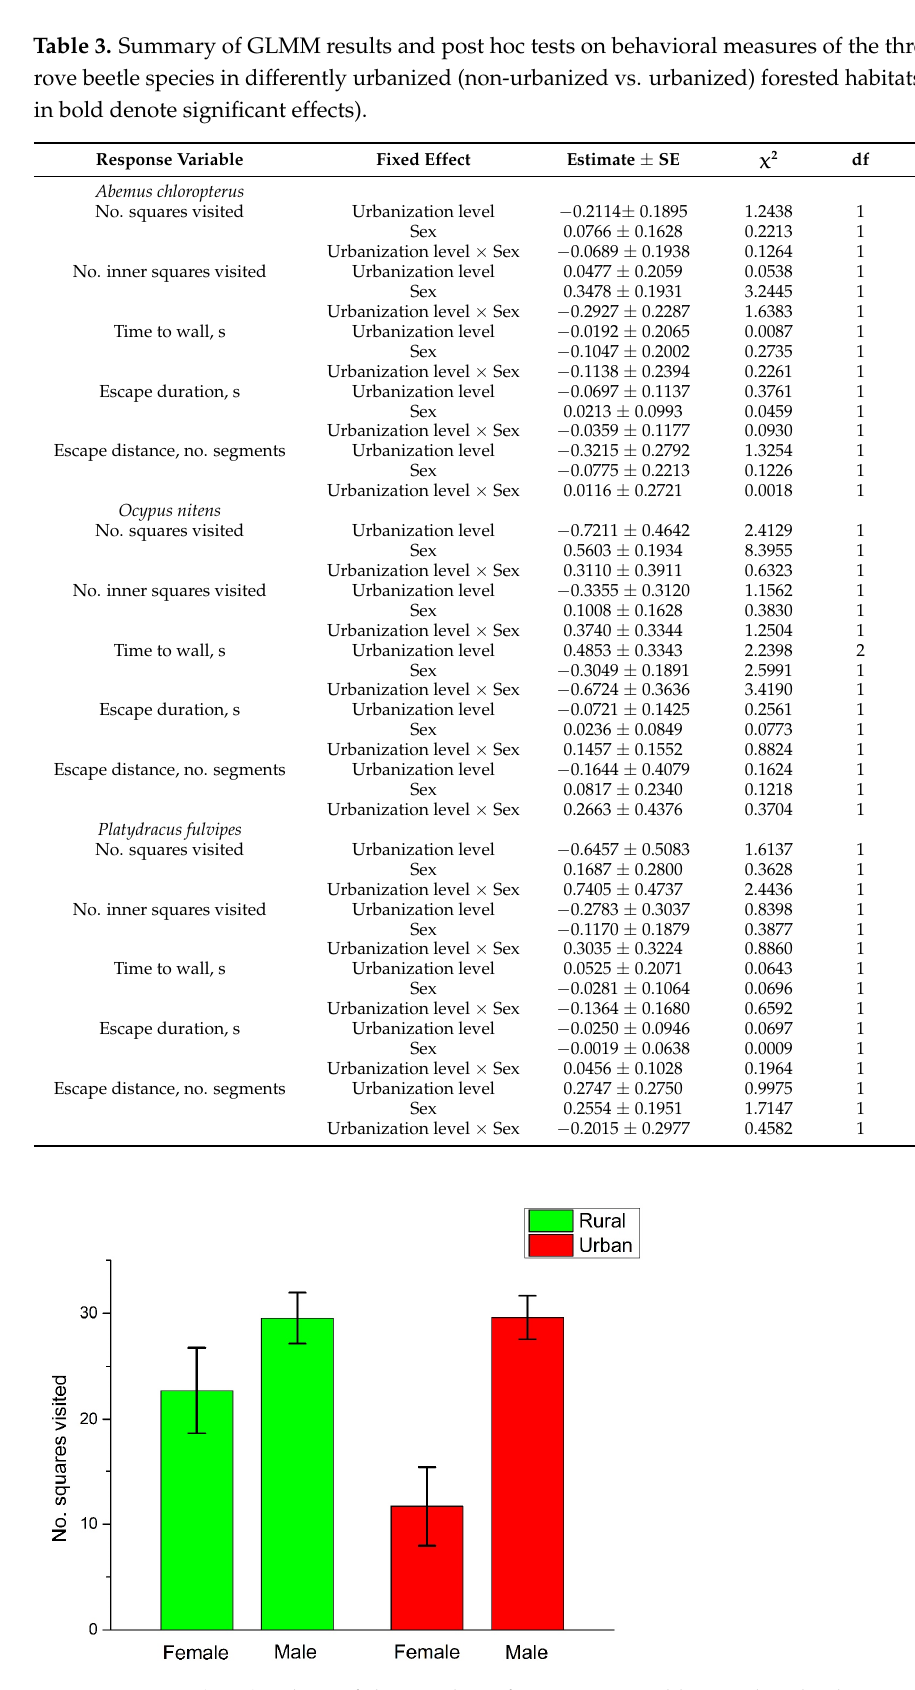
Figure 2. Mean (±SE) values of the number of squares visited by rural and urban Ocypus nitens in- Figure 2. Mean ( ± SE) values of the number of squares visited by rural and urban Ocypus nitens dividuals.